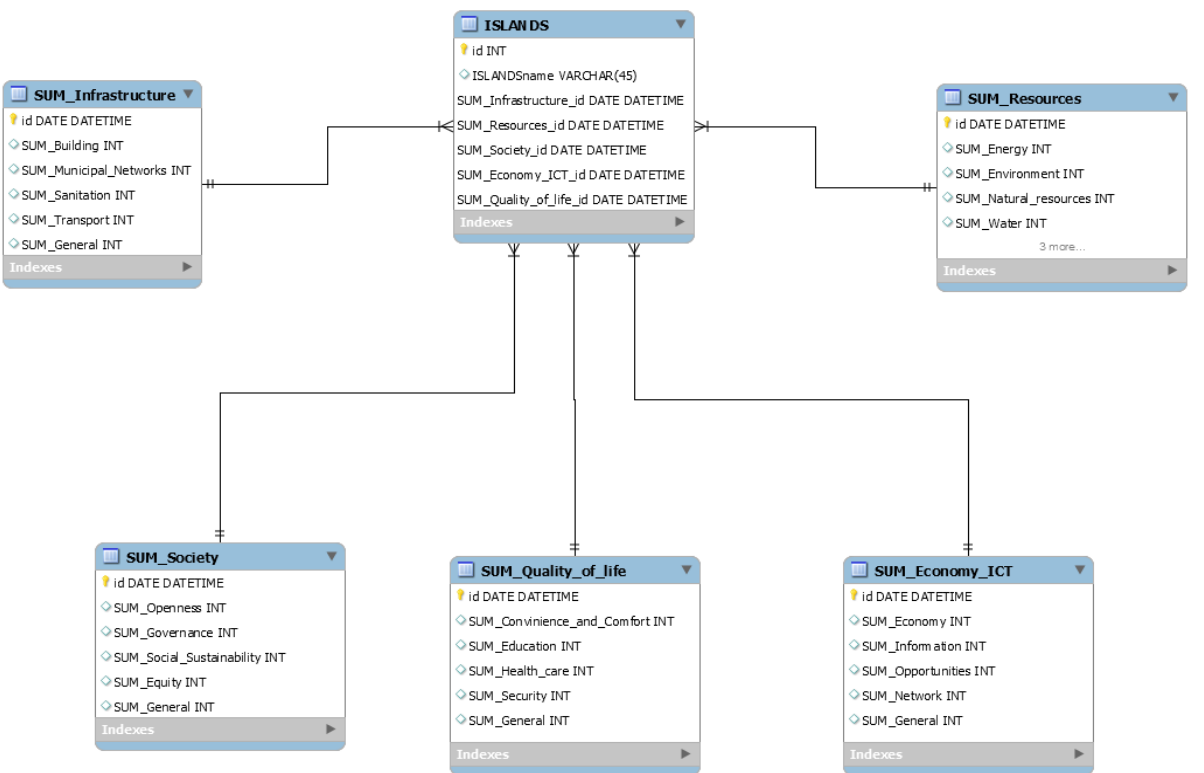
Figure 3. Relation diagram for the five entities of the inner circle of the figure 1: Economy & ICT, Resources, Society, Quality of Life,